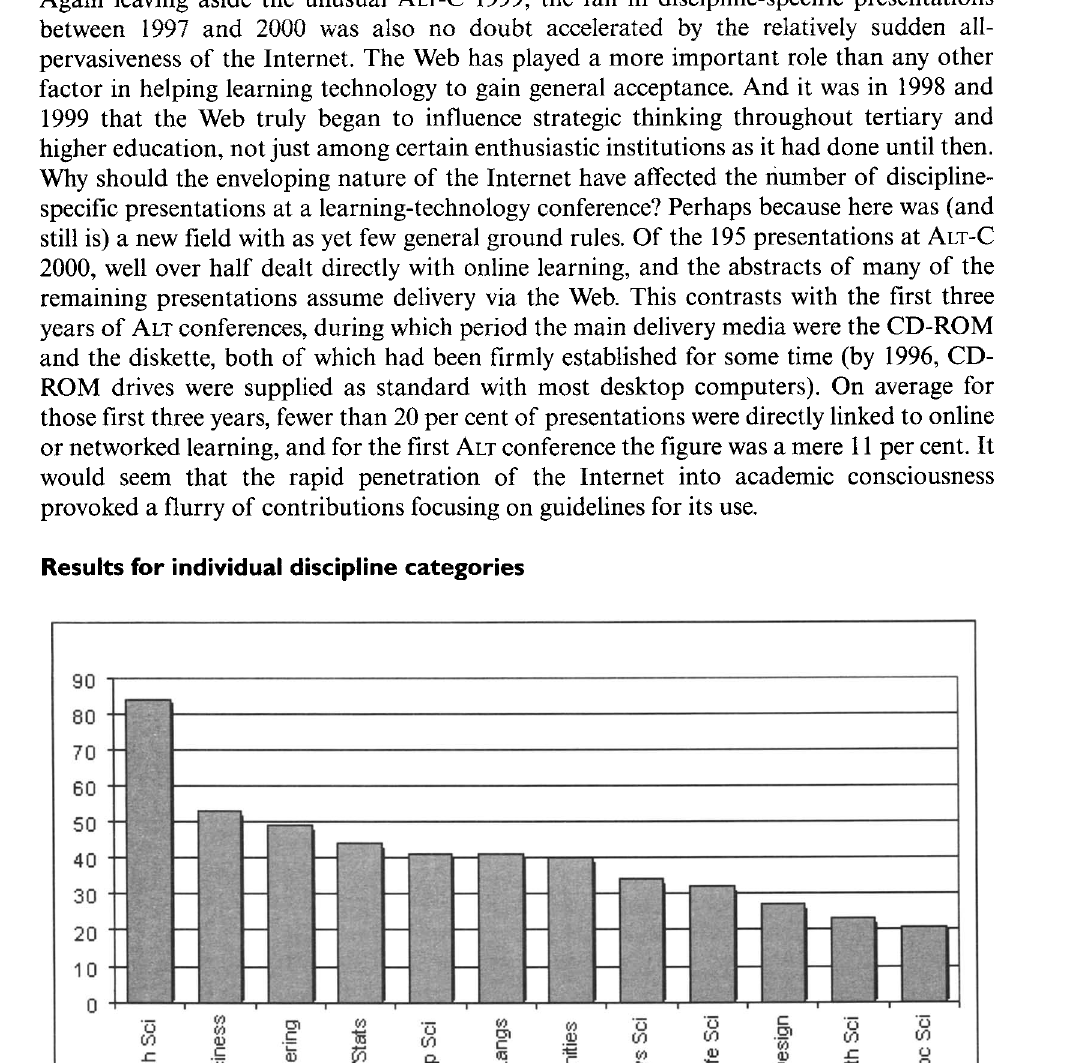
Figure Overall totals of discipline-specific 3: